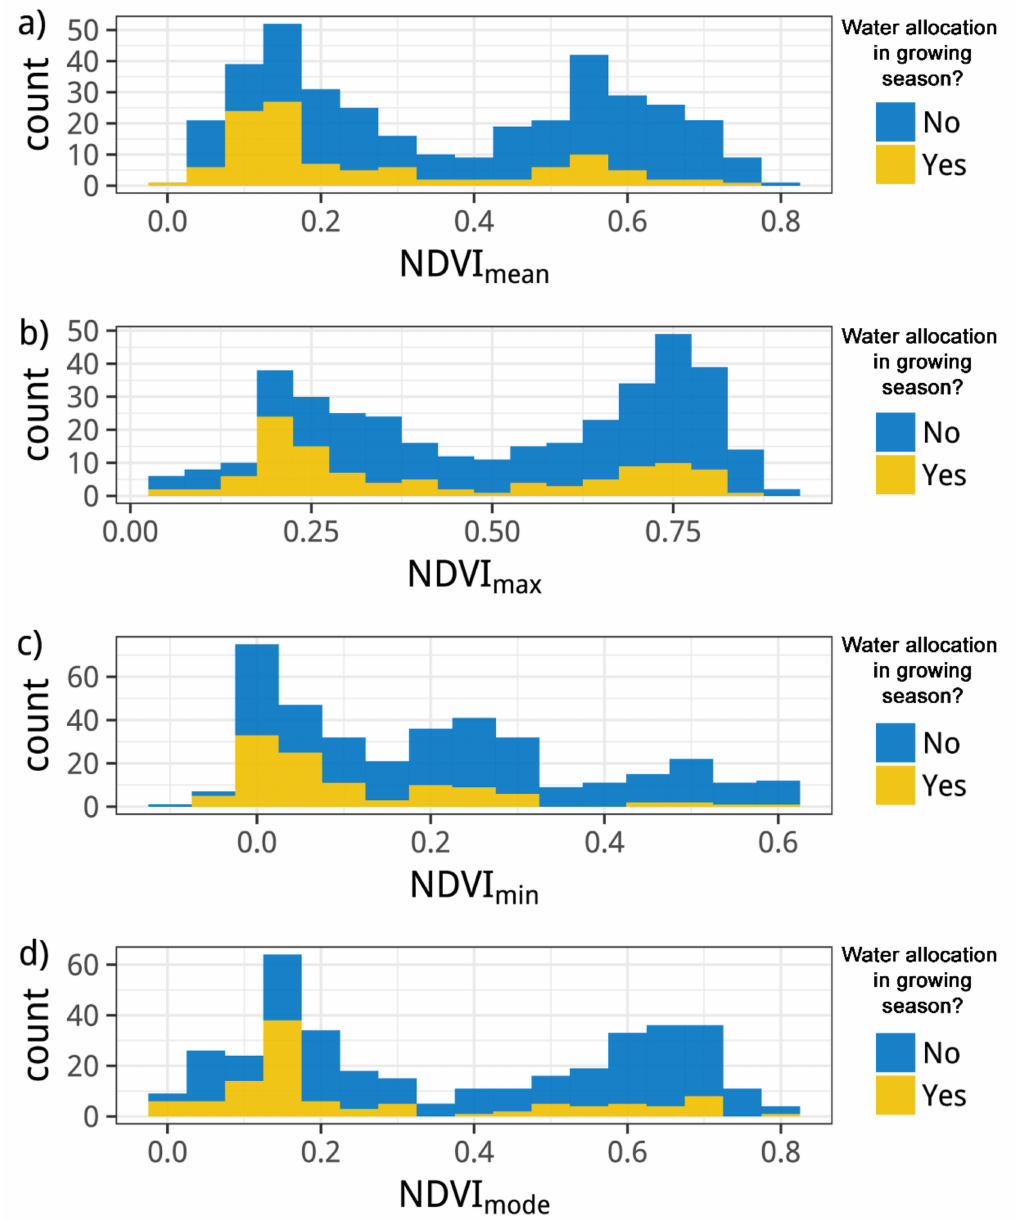
Figure 2. Histogram showing the frequency distribution of ( a ) NDVI mean , ( b ) NDVI max , ( c ) NDVI min , and ( d ) NDVI most